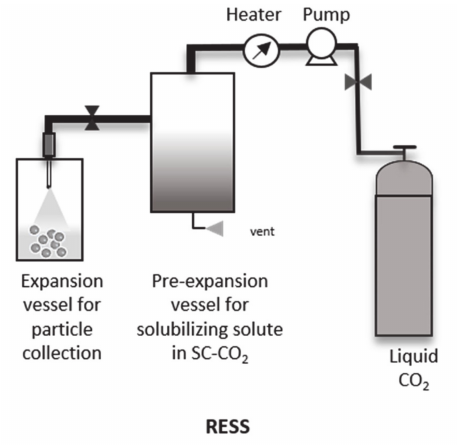
Figure 3. Schematic representation of the RESS